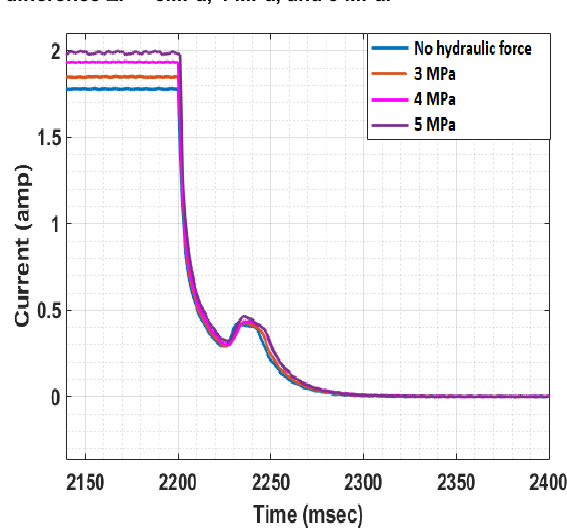
Figure 12 Current measured when the solenoid is energized under no applied hydraulic force and pressure difference ∆ P = 3MPa, 4 MPa, and 5 MPa.